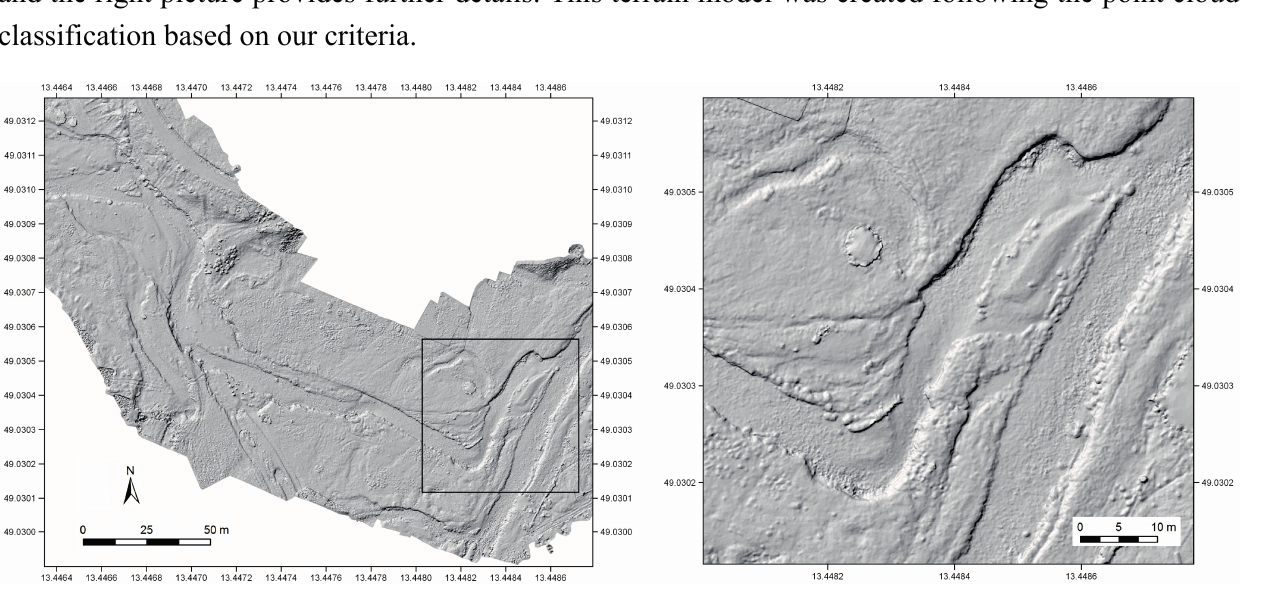
Figure 7. Digital terrain model of the study area resulting from an aerial imaging (May